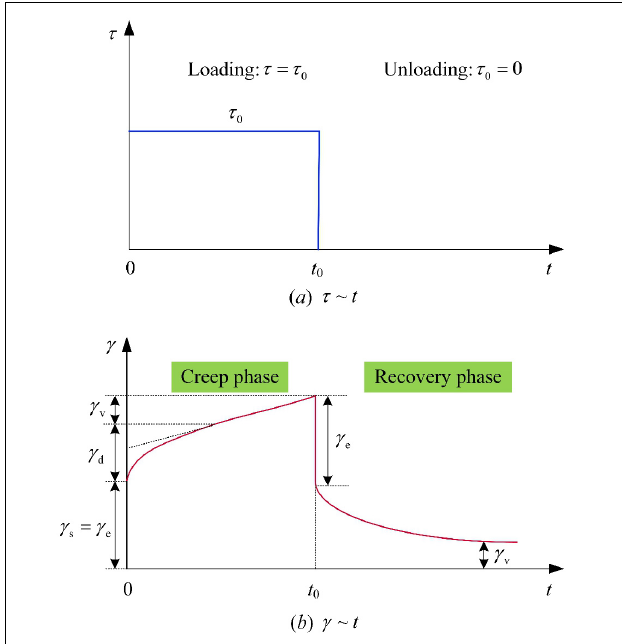
FIGURE 2 | Creep and recovery behavior to an applied constant stress for linear viscoelastic materials.